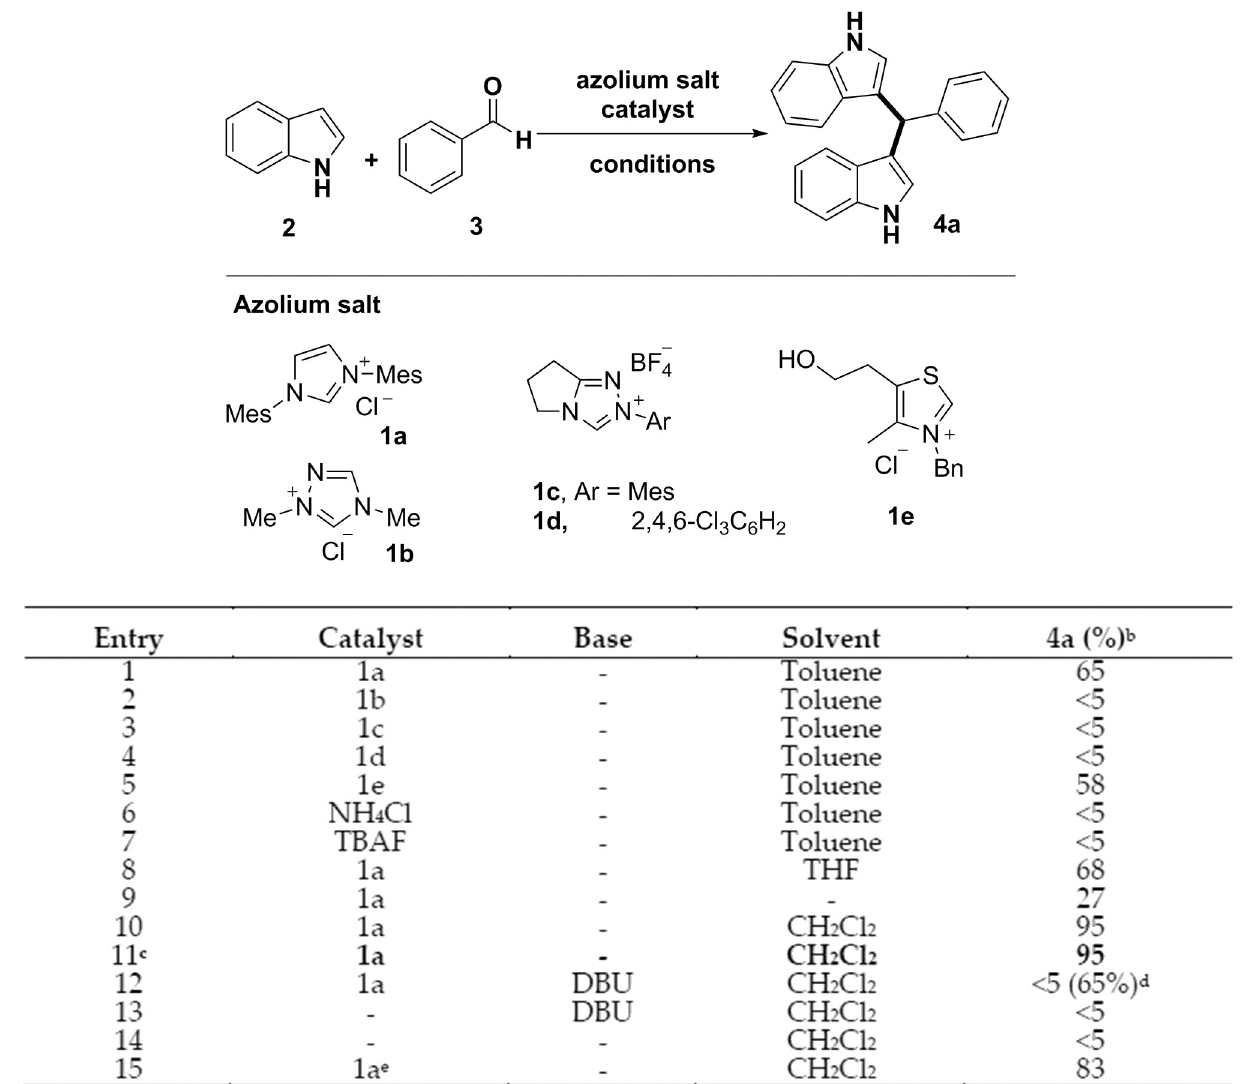
Fig 3. Optimization of the reaction conditions a